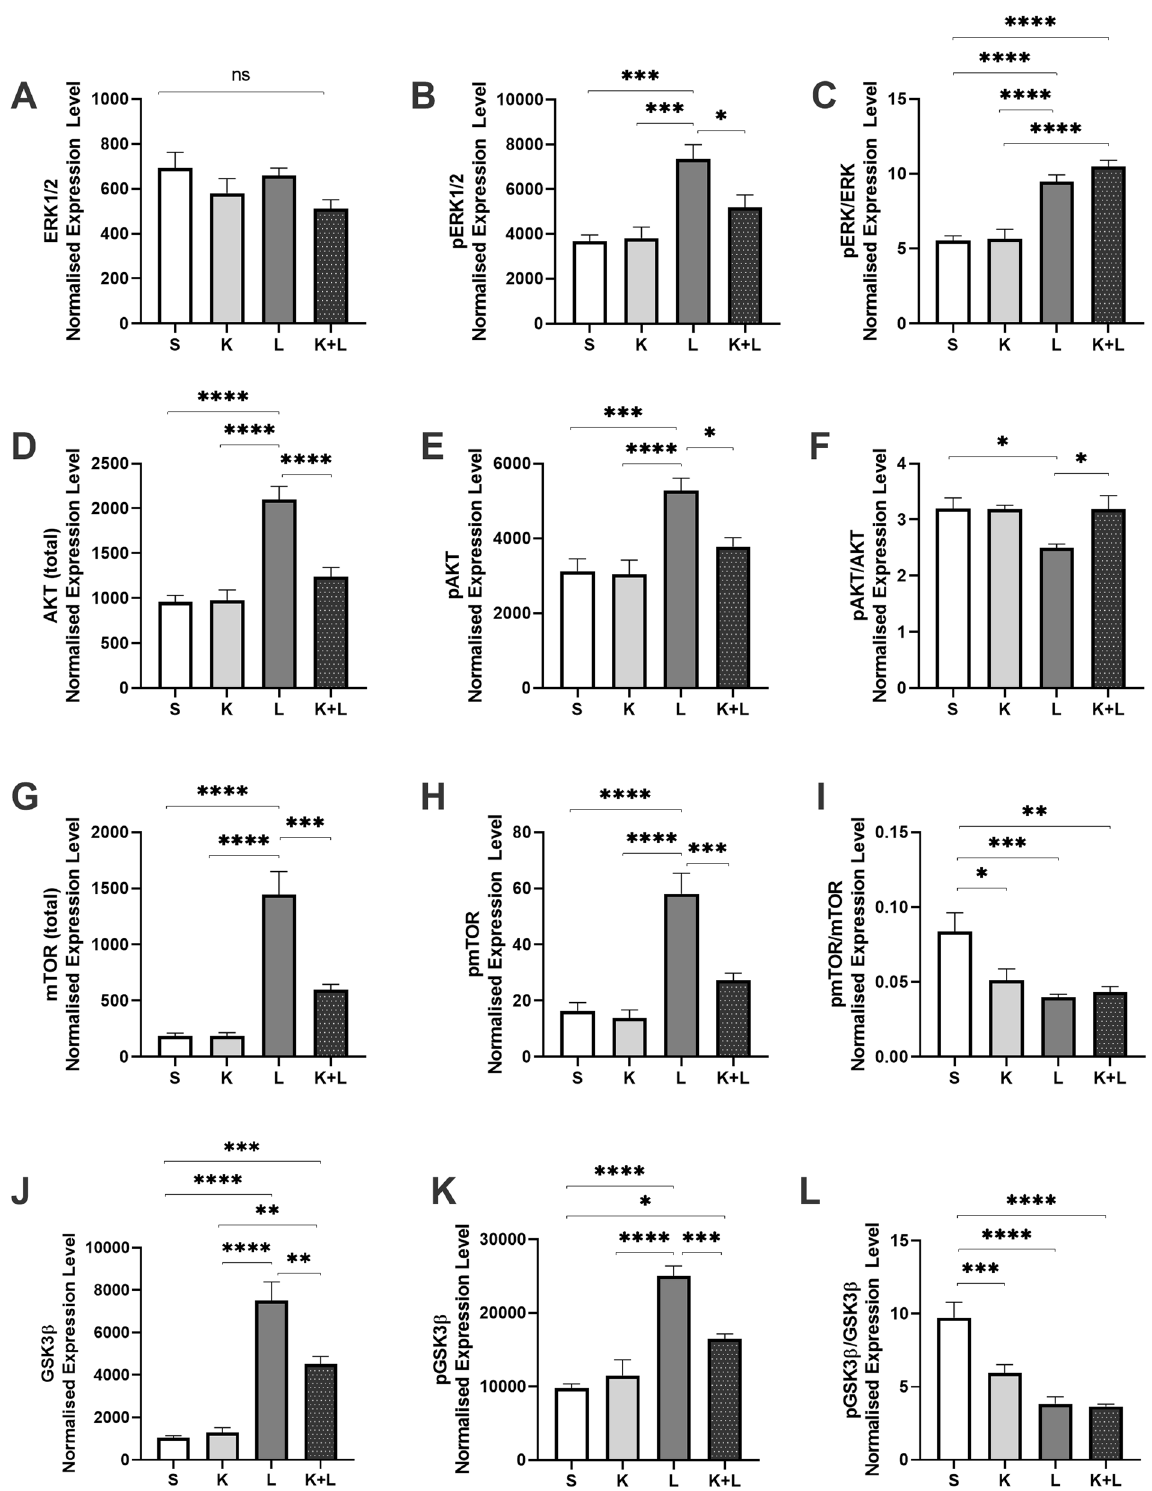
Fig. 4 Prelimbic cortex protein expression in response to treatment. The effect of ketamine and lithium treatment on protein signaling pro fi les in the infralimbic cortex were examined via western blotting. Proteins of interest include total ERK1/2 ( A ), p ERK1/2 ( B ), p ERK1/2/ERK1/2 ( C ), total Akt ( D ), p Akt ( E ), p Akt/Akt ( F ), mTOR ( G ), p mTOR ( H ), and p mTOR/mTOR ( I ), GSK3ß ( J ), p GSK3ß ( K ), and p GSK3ß/GSK3ß ( L ). ERK1/2 extracellular signal-regulated kinases 1/2, p phosphorylated, Akt protein kinase B, mTOR mammalian target of rapamycin, GSK3ß glycogen synthase kinase-3 ß. Treatment groups: S: saline, K: ketamine, L: lithium, K + L: ketamine + lithium. * p < 0.05; ** p < 0.01; *** p < 0.001; **** p <